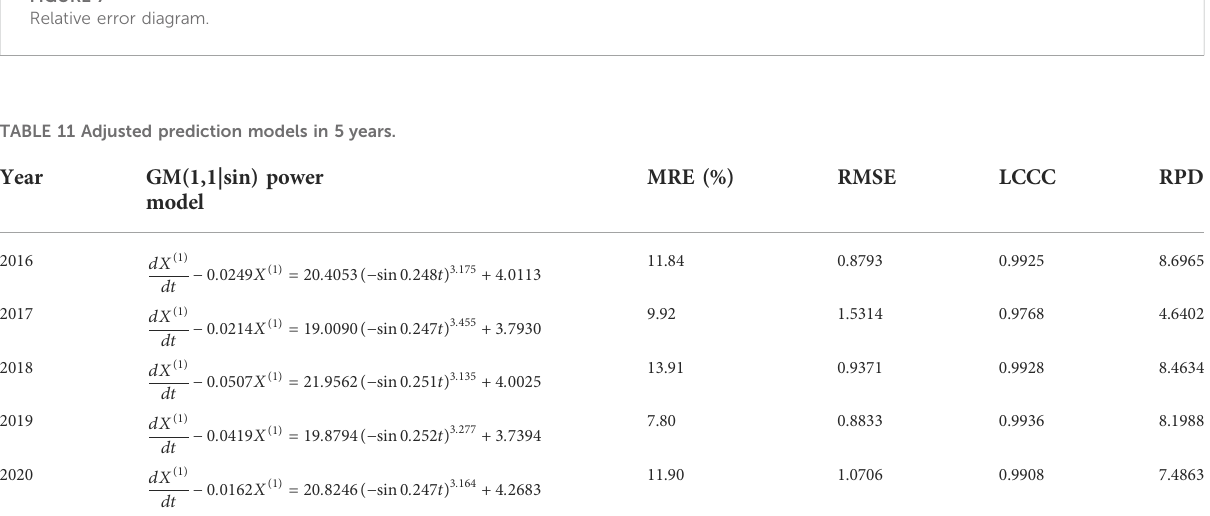
FIGURE 7 Relative error diagram.